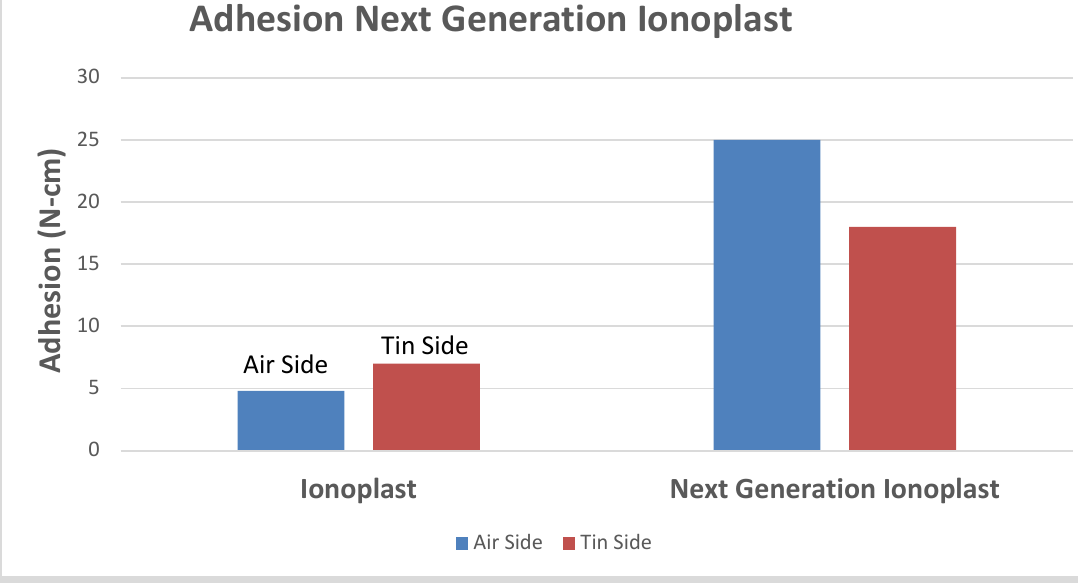
Fig. 6 Peel Adhesion of Next Generation